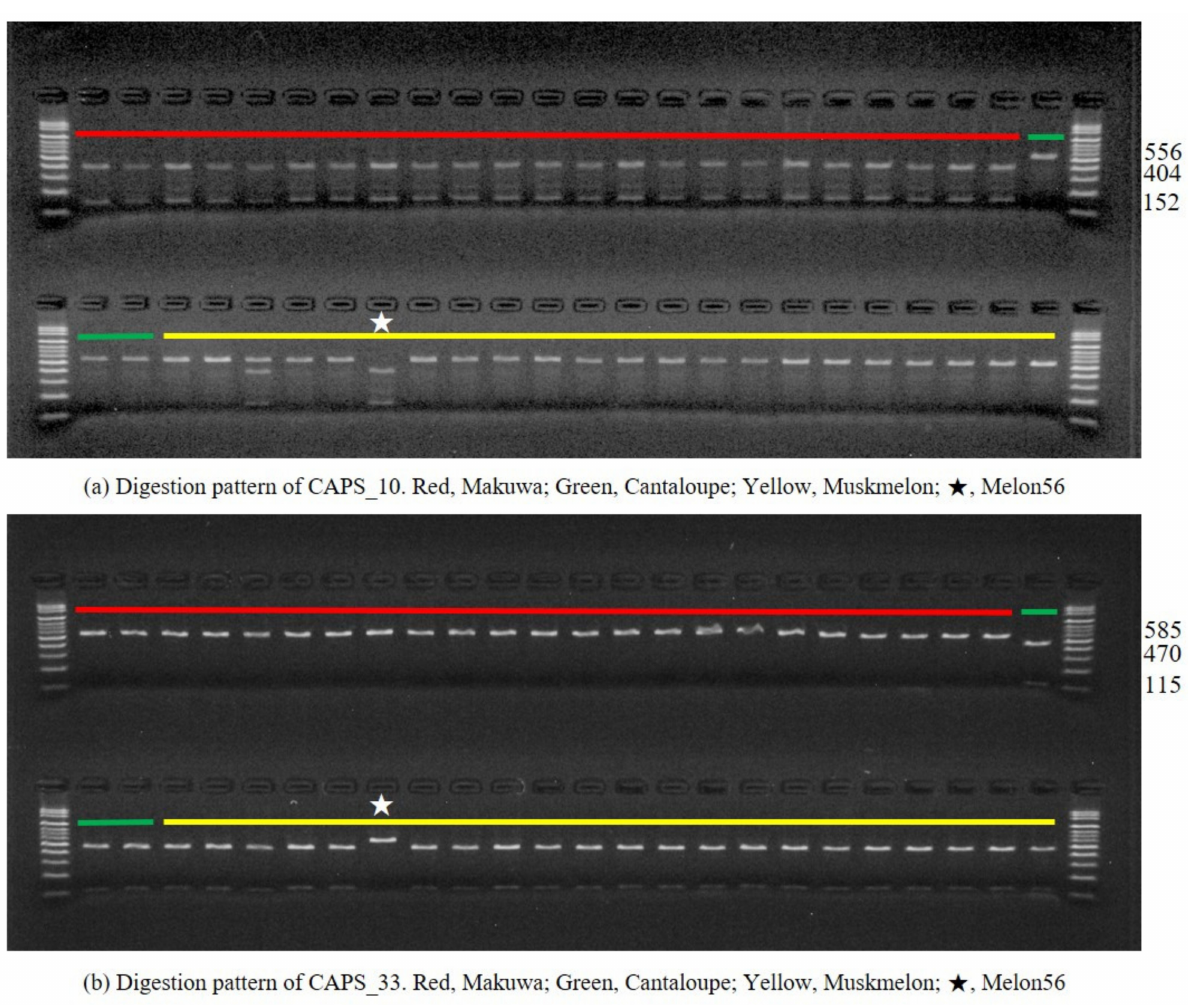
Figure 5. Gel electrophoretic image of cleaved amplified polymorphic sequence (CAPS) polymorphism of polymerase chain reaction products digested with ( a ) Bcc I and ( b ) Bsr